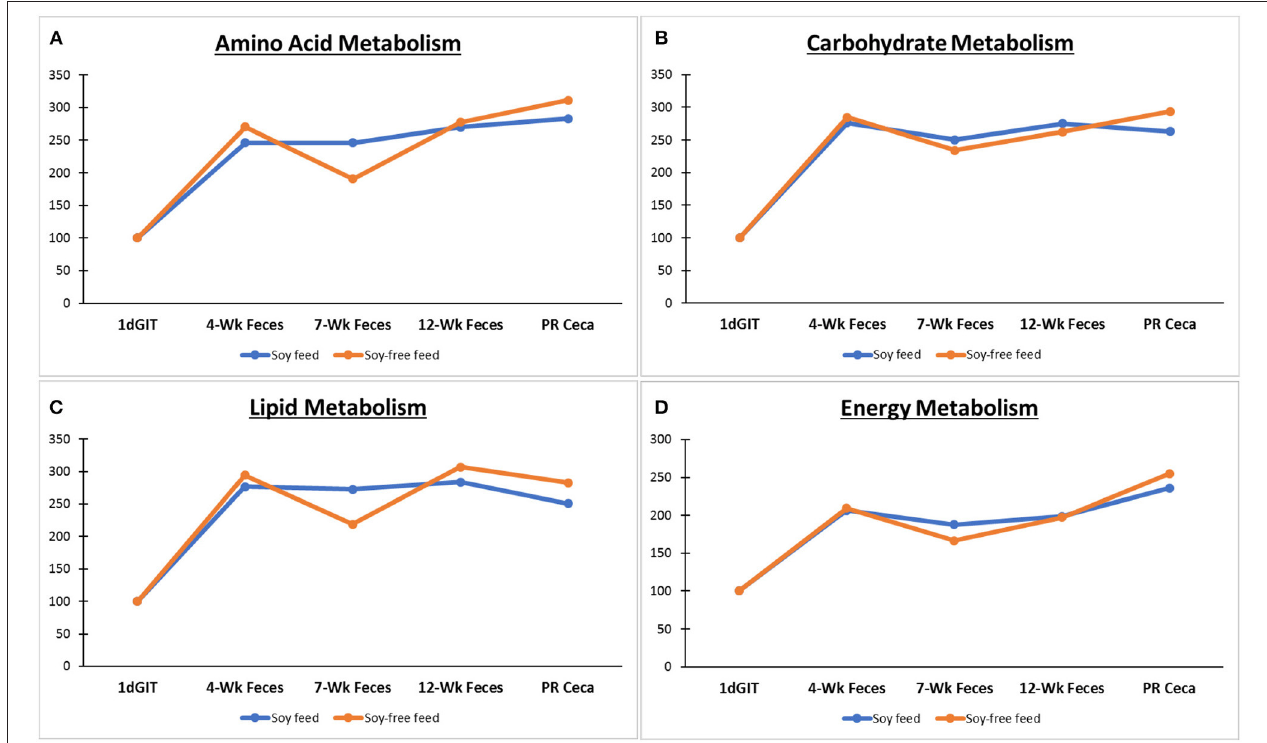
FIGURE 6 | Predicted metabolic functions (level 2 KEGG pathways using PICRUSt) based on the microbiome of broilers fed the soy-containing and soy-free diets: 1dGIT, Gastrointestinal contents from 1-day-old broilers; 4WFeces, Feces from 4-week-old broilers; 7WFeces, Feces from 7-week-old broilers; 12WFeces, Feces from 12-week-old broilers; PRCeca, Cecal contents collected during slaughter. Pathways associated with the metabolism of: (A) Amino acids; (B) Carbohydrates; (C) Lipids; and (D) Energy. No differences were detected between the 2 diets ( P ≥ 0.26) for any of the pathways. TABLE 1 | Correlations between broiler age and selected bacteria a as well as their respective relative abundances for birds fed the soy-containing feed*. Item Pearson Correlation 1dGIT 4WFeces 7WFeces 12WFeces